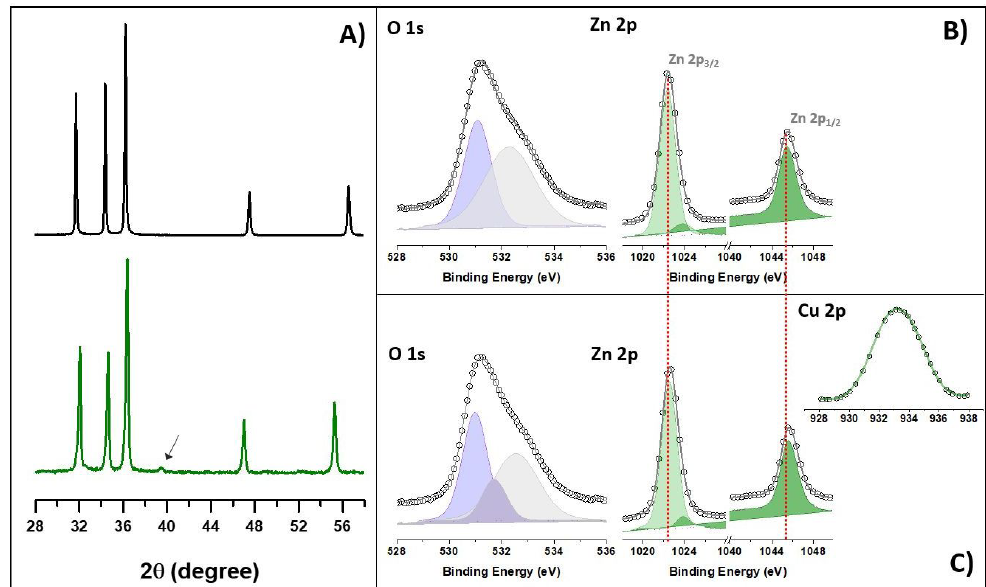
Figure 3. Structural characterization of ZnO and Cu-ZnO. A) X-ray diffraction of ZnO; B) XPS spectra of O1s, Zn2p of ZnO and C) XPS spectra of O1s, Zn2p of ZnO and Cu2p of